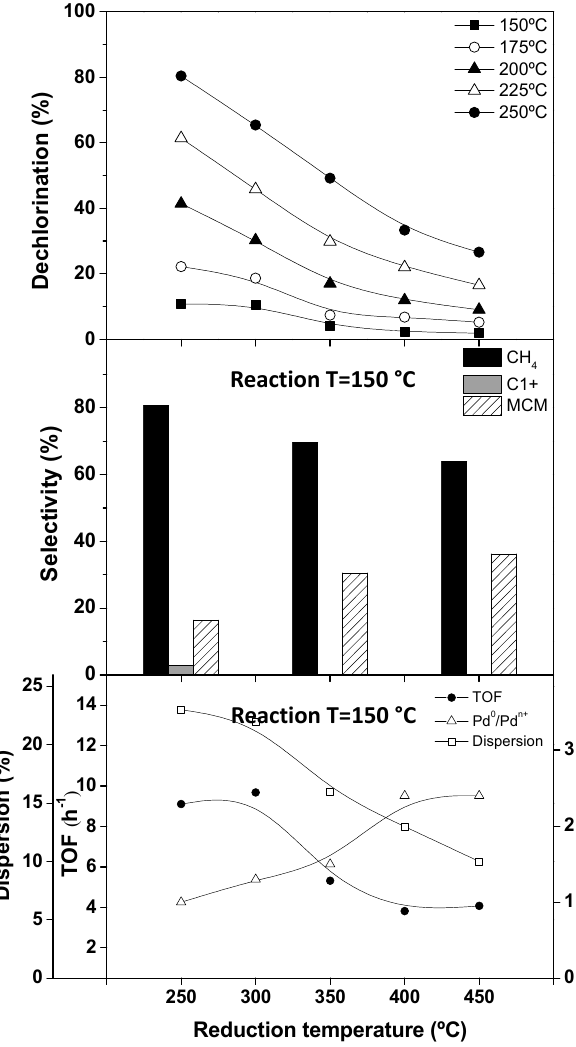
Figure 5. Results on the HDC of DCM within 150–250 °C reaction temperatures, at 0.6 kg cat ∙ h ∙ mol − 1 space ‐ time, with the Pd/C catalyst reduced at different temperatures.